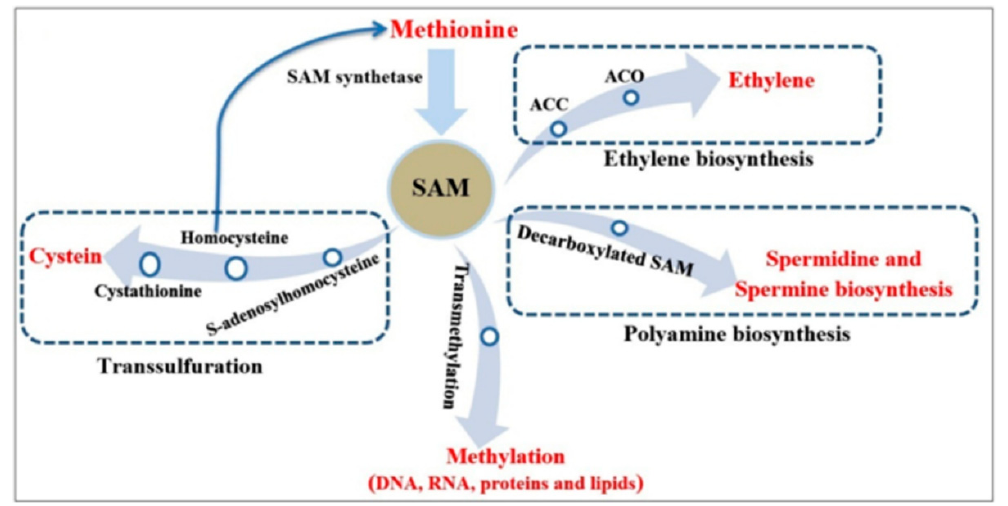
Figure 1. Metabolic and biosynthesis pathways involving SAM.